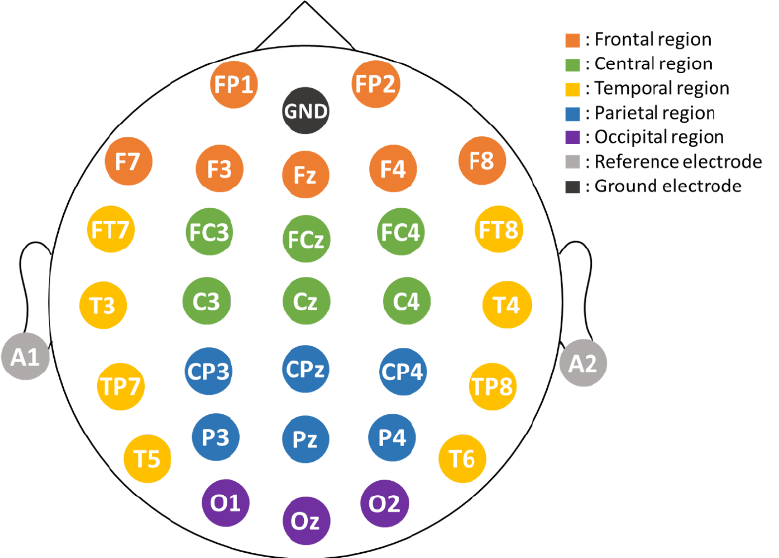
Figure 2. Layout of the electrodes. Their positions follow the 10–20 international system. Ground (GND) electrode is at the forehead, and two references are at A1 and A2, respectively. For analysis, we divided the entire scalp area into five different regions, including frontal (brown), central (green), parietal (blue), occipital (purple), and temporal (yellow).